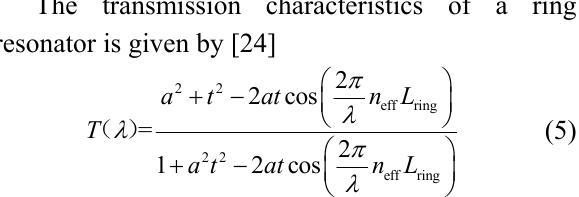
Fig. 8. Schematic diagram of the MRR sensor employing a polymer horizontal slot waveguide in the racetrack waveguide as light-analyte interactive region. Inset: cross-sectional view of the conventional strip waveguide (left) and the horizontal slot waveguide